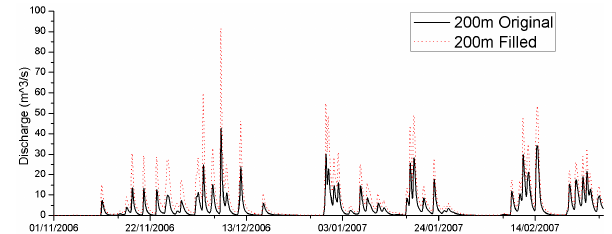
Fig. 10. Surface flow simulations for the 200m resolution DEM in MIKE SHE.